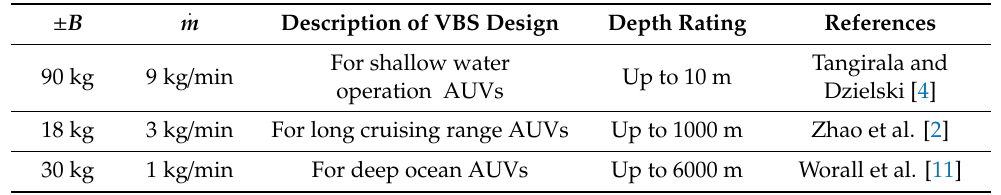
± and m  options. . m